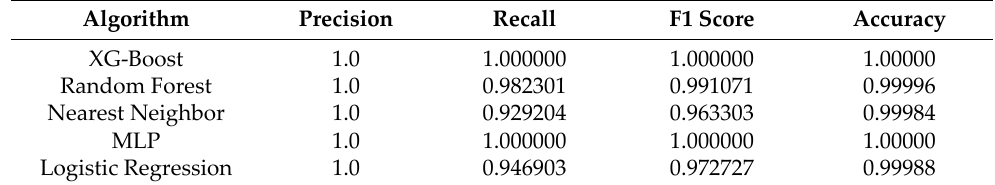
Table 12. Comparison of classification models using the K‑CGAN synthetic data only (sample of 30,000 valid and 30,000 fraud transactions generated by K‑CGAN